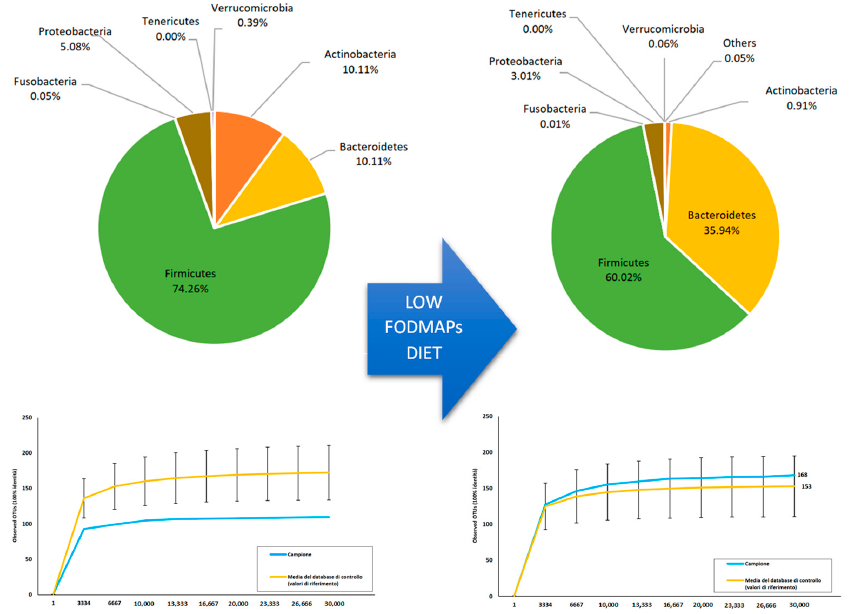
Figure 1. Variation in taxonomic composition and biodiversity following a low-FODMAP diet .